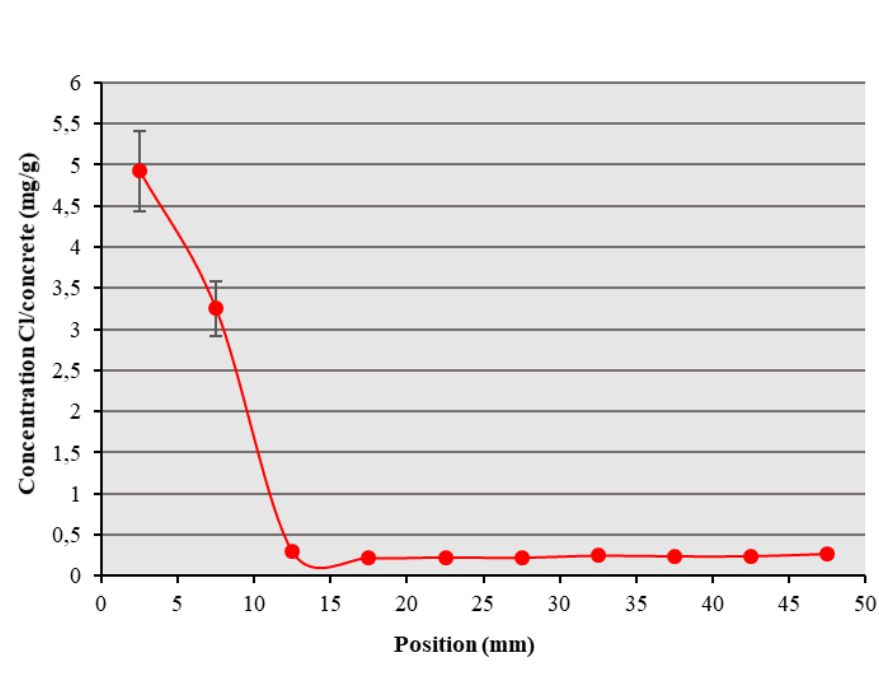
Figure 4. Concentration profile in N samples.